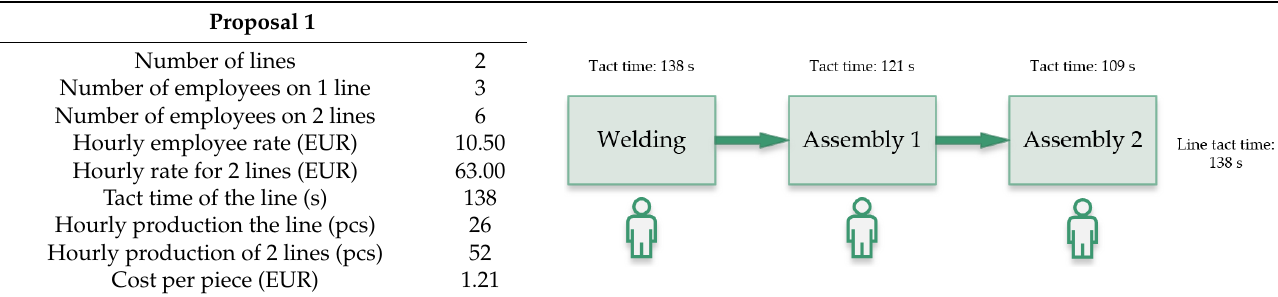
Table 7. Proposal 1. Table 7 . Proposal